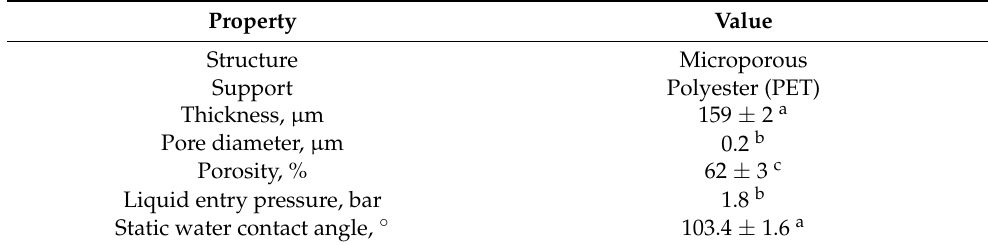
Table 1. Characteristics of the flat-sheet PVDF membrane.